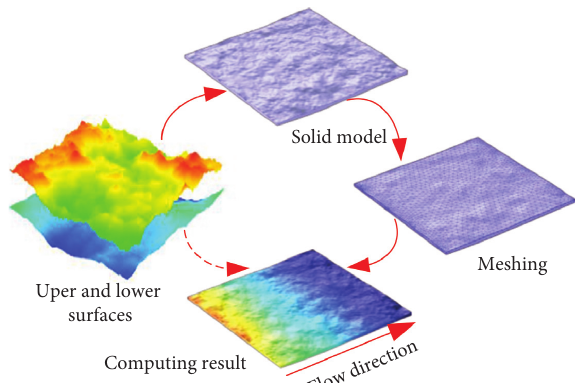
Figure 3: Modelling process of nonlinear flow through 3D rough Table 1: The values for linear coefficient A and nonlinear coefficient B . Standard deviation of aperture (mm)